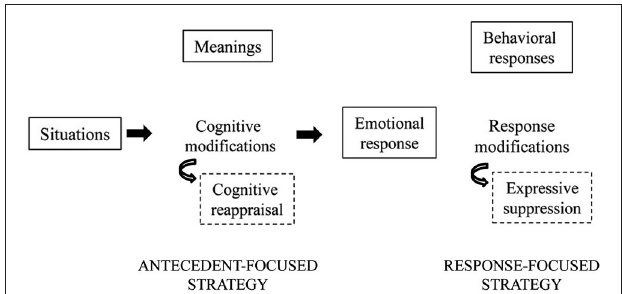
FIGURE 1 | A schematic representation of emotion regulation . During the generative emotion processing, emotional situations can be managed modifying the emotional stimuli before the emotional response (antecedent-focused strategies) or still during the emotional response (response-focused strategies). In the first case cognitive modifications of the situation meaning can be used (i.e., cognitive reappraisal). Otherwise, a modulation of behavioral and physiological responses can be performed (i.e., expressive suppression). Here we are focusing on reappraisal and suppression strategies, anyway other antecedent-focused (e.g., situation selection and modification, attentional deployment) or response-focused (e.g., use of drugs, social sharing, relaxation) strategies can be used in regulating everyday affective experiences.